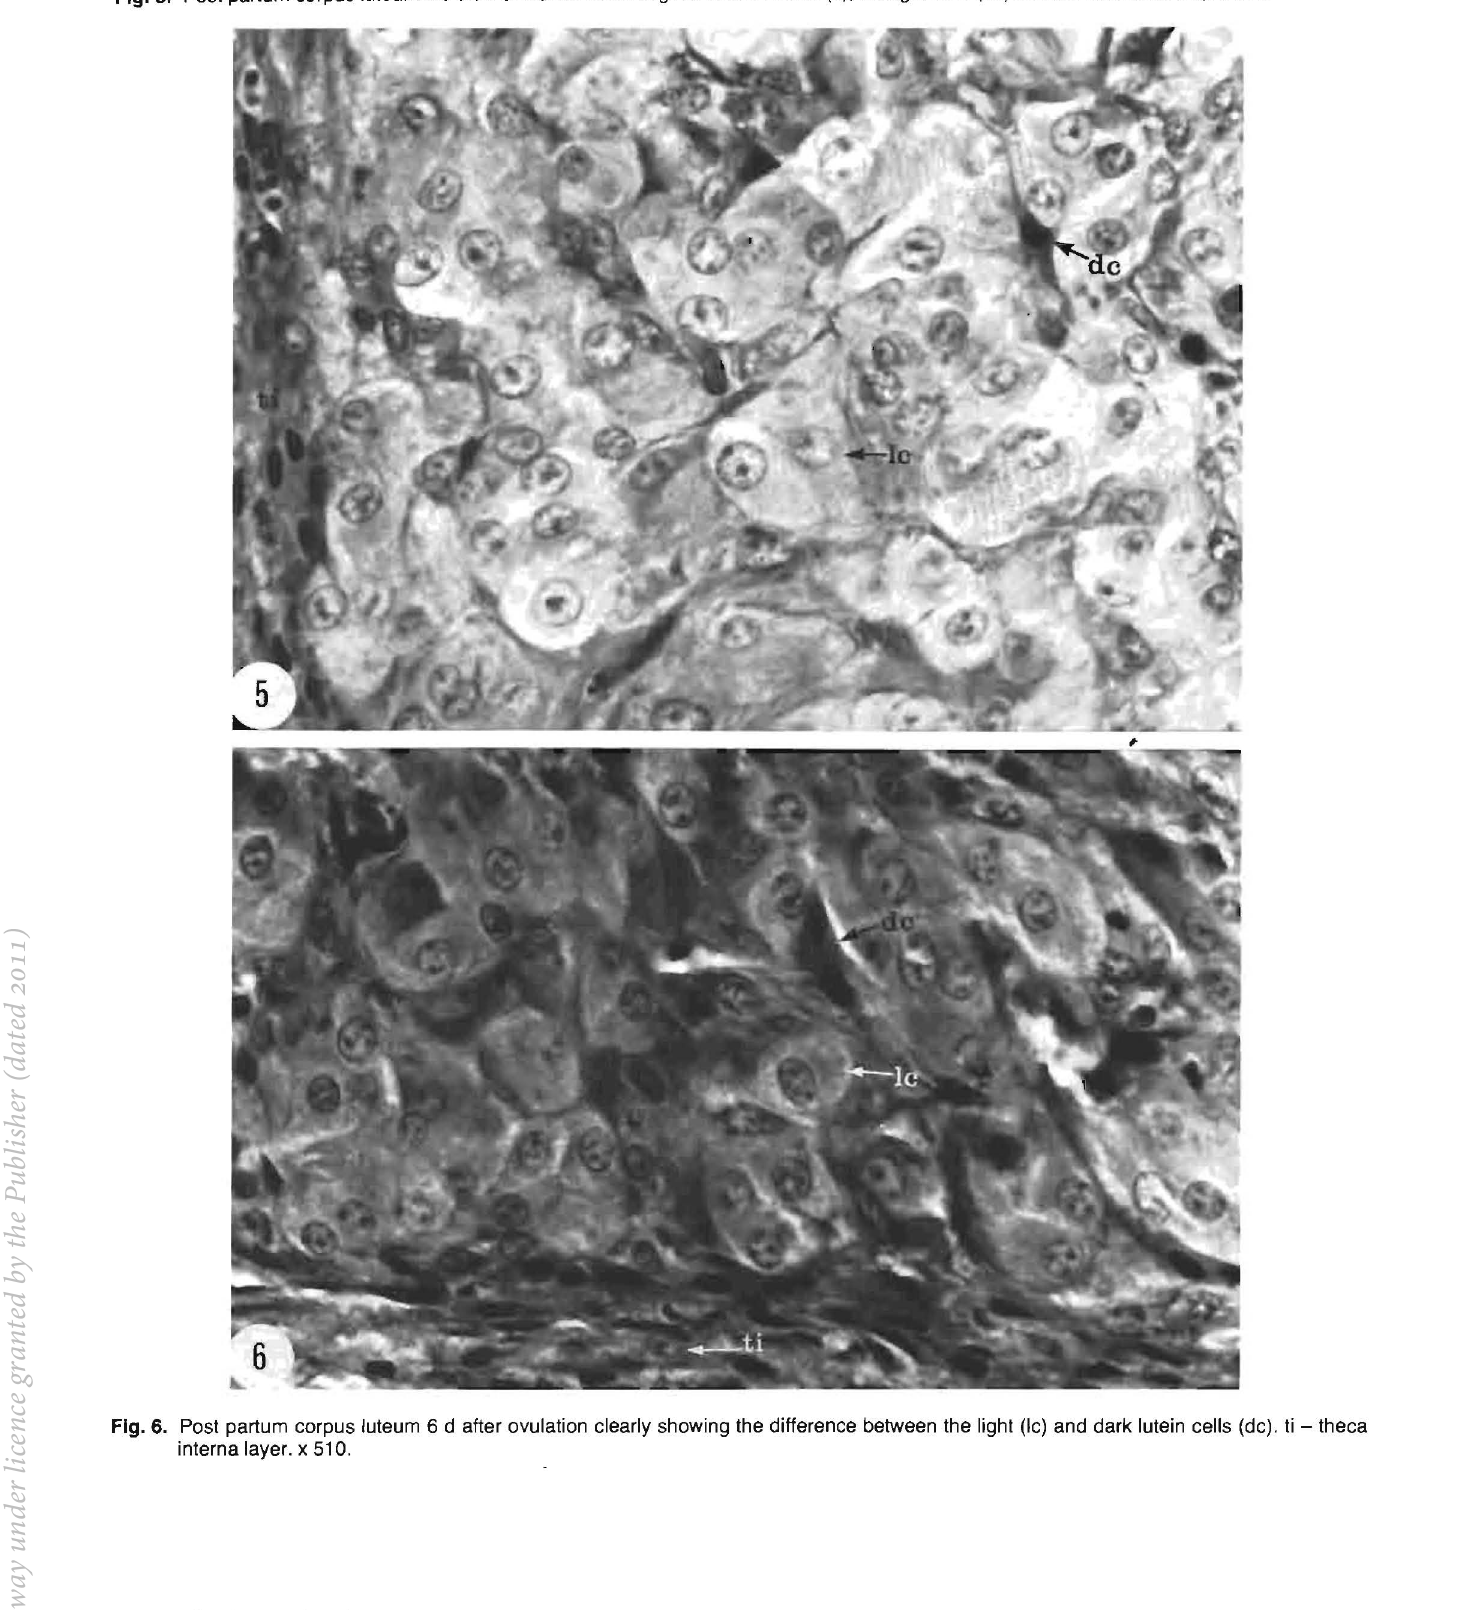
nary Services and Animal Industries, Union of South Africa 663--703